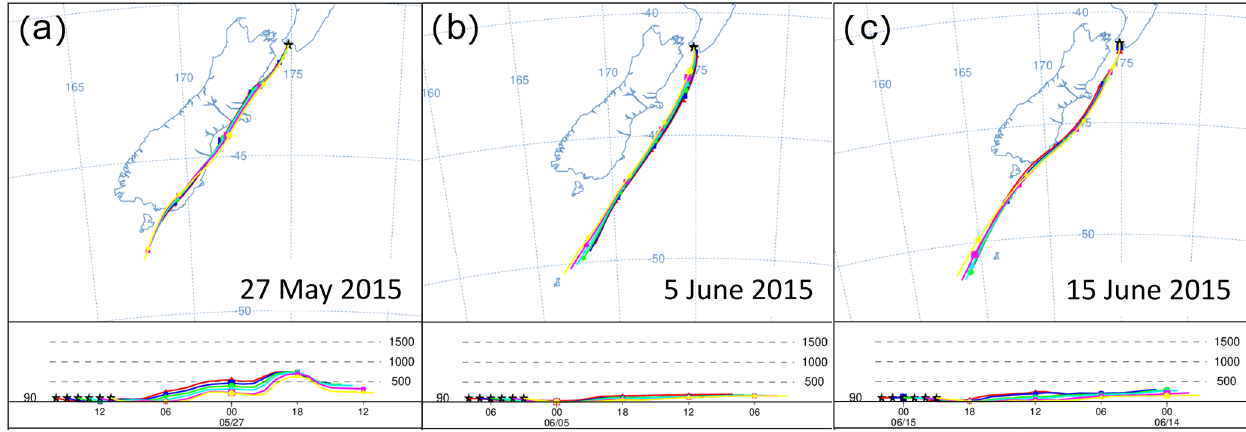
Figure 7. HYSPLIT back trajectories (24h) for the air measured during S1, S2 and S3, with a 1h interval between displayed trajectories. The selected timing is consistent with the final 6h of each event displayed in Fig. 16 with the lowest radon counts.